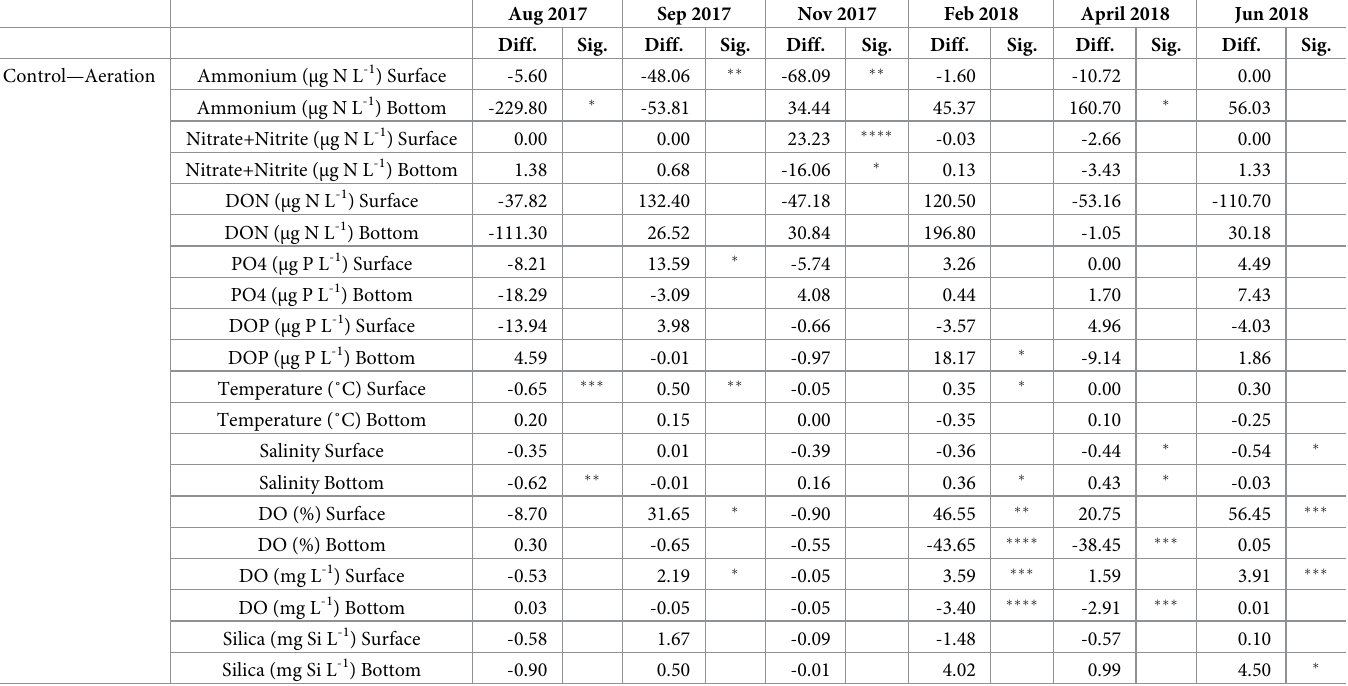
Table 2. Summary of outcomes of statistical comparisons of control and aeration canals as a function of environmental parameters and temporal changes.